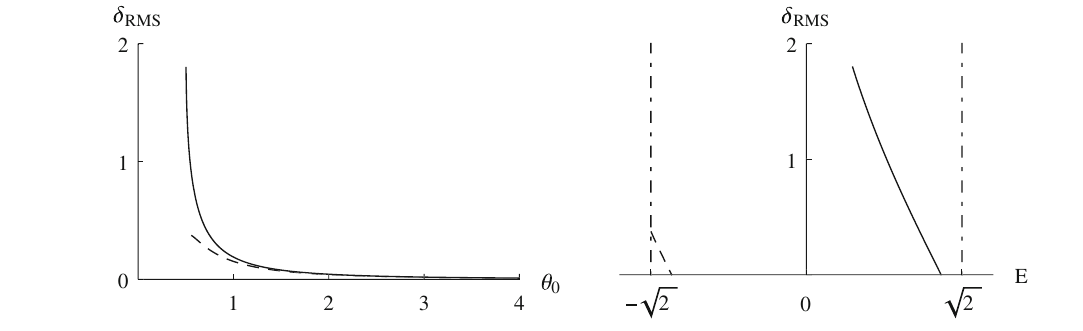
tive bound energies, respectively, in the dynamical model. Dotdashed lines are the threshold energies in the background